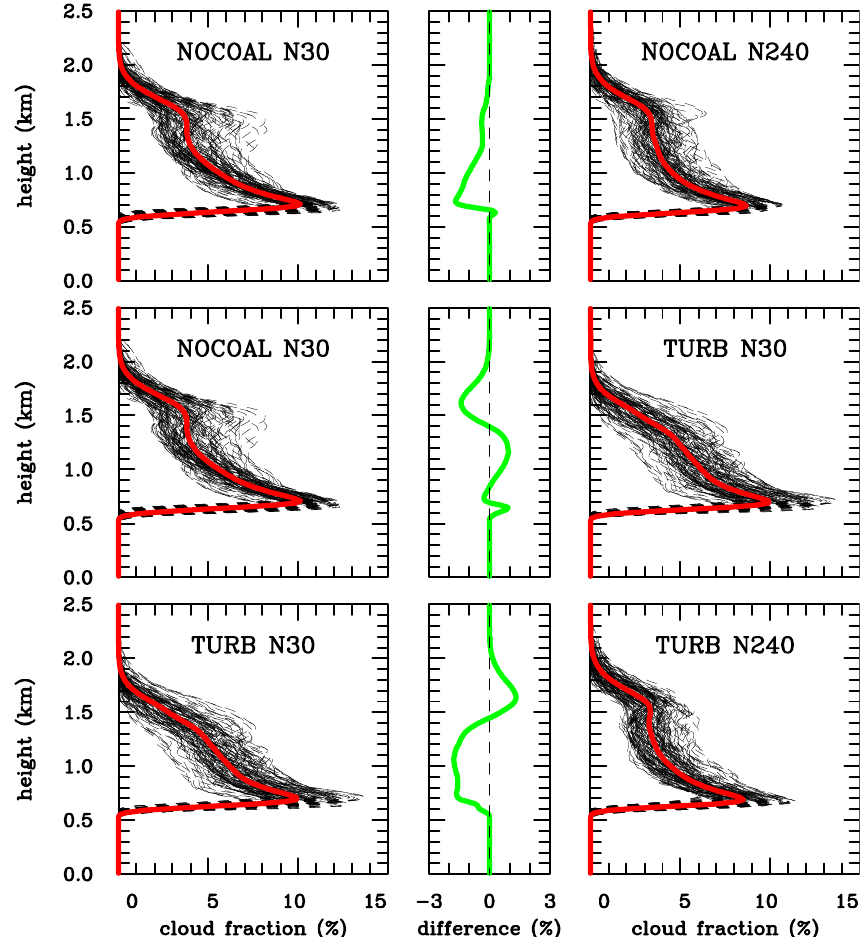
Figure 6. Cloud fraction profiles for selected simulations. Dashed black lines are profiles every minute for the last 3h and the red solid lines are average profiles for that period. The middle panels (green lines) show differences between the right and the left mean profiles.